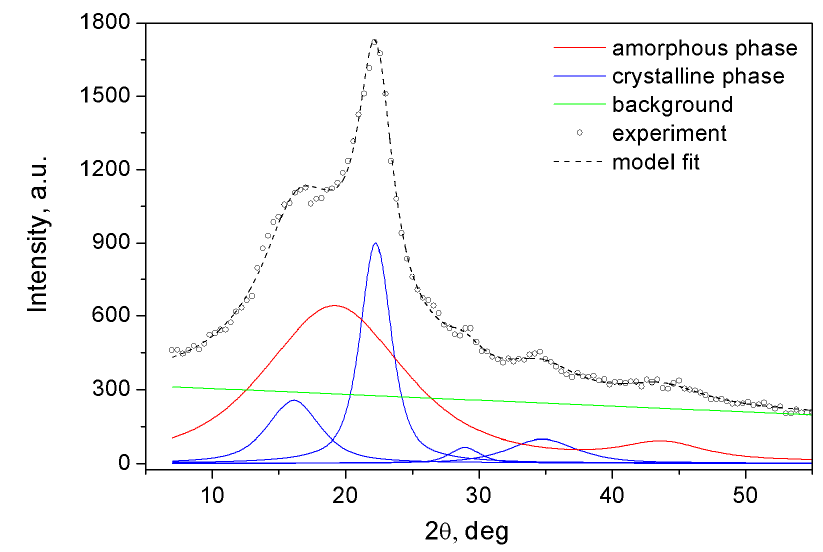
Figure 3. Profile analysis of the diffraction pattern of the raw